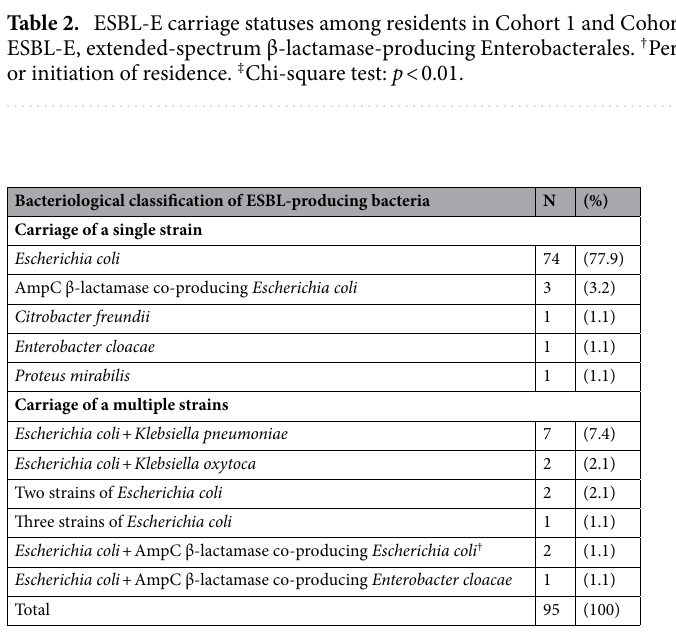
Table 3. Classification of ESBL-producing bacteria detected in fecal specimens from residents. ESBL, extended-spectrum β-lactamase. † One strain met the definition of carbapenem-resistant Enterobacteriaceae